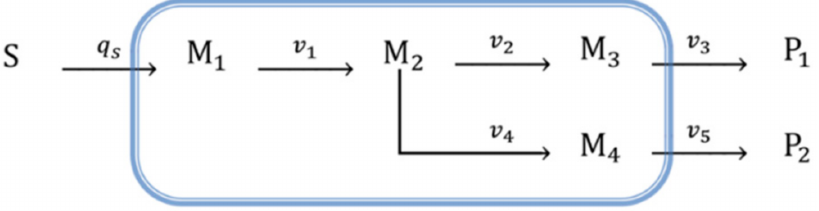
Figure A1. Simplified metabolic network of growing microbial cells. The limiting nutrient substrate S is transformed via intracellular intermediates M1–M4 into the extracellular products P1 and